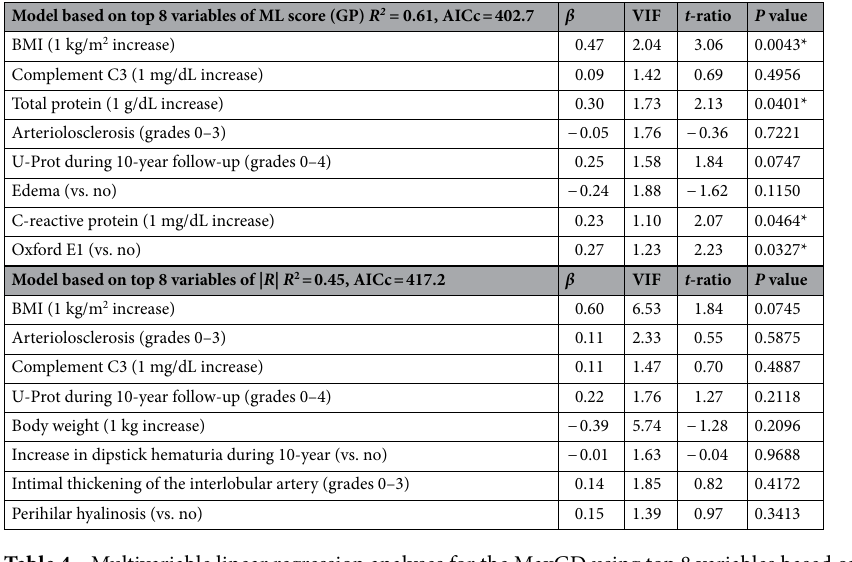
Table 4. Multivariable linear regression analyses for the MaxGD using top 8 variables based on ML score (GP) or | R | * P < 0.05. Top 8 variables based on ML score (GP) or | point-biserial r| were included in the multivariate model. Abbreviations: MaxGD, maximal glomerular diameter; ML, machine learning; GP, genetic programming; |R| , the absolute value of point-biserial correlation coefficient; R 2 , R -squared; AICc, small- sample corrected Akaike Information Criterion; β , standardized partial regression coefficient; VIF, variance inflation factor; BMI, body mass index; C3, component 3; U-Prot, Urinary protein excretion; Oxford E1, the presence of endocapillary hypercellularity.